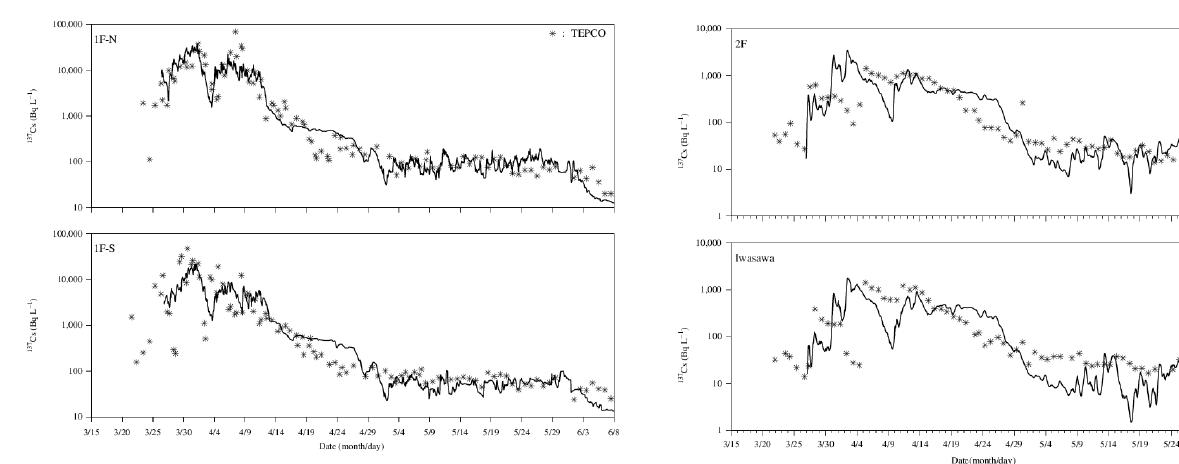
Fig. 6. Comparisons of model-computed and observed 137 Cs concentrations at 2F and Iwasawa over the period 26 March– 8 June